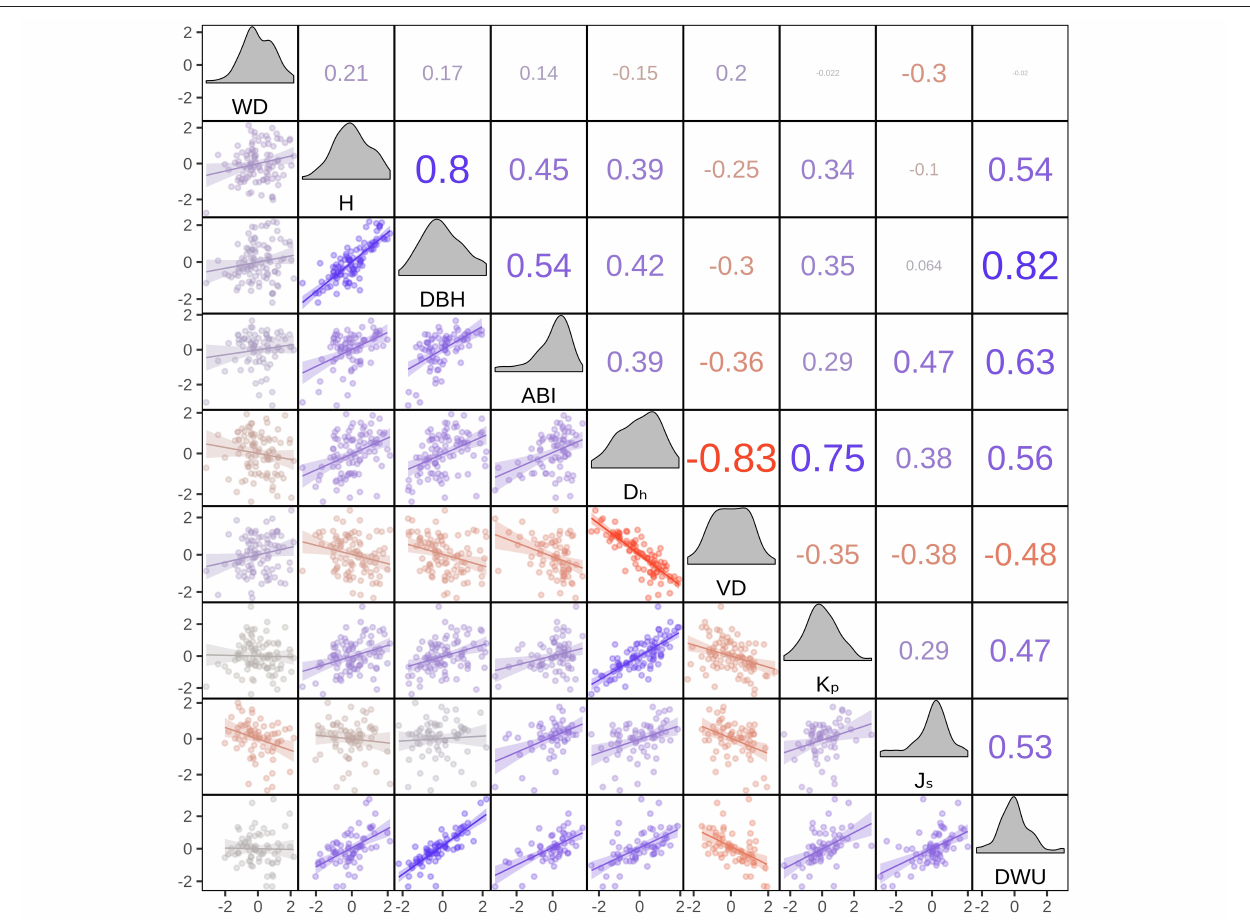
FIGURE 2 | Pairwise Pearson correlation table (upper triangle), scatterplots (lower triangle), and density plots (diagonal panels) for the transformed variables used for model fitting. Shown are the species means of the ln–transformed (with the exception of WD ), scaled and centered structural characteristics and hydraulic traits for n = 99 species, including trend lines from linear regression with 95% confidence intervals. Color and size indicate direction and strength of the correlation.